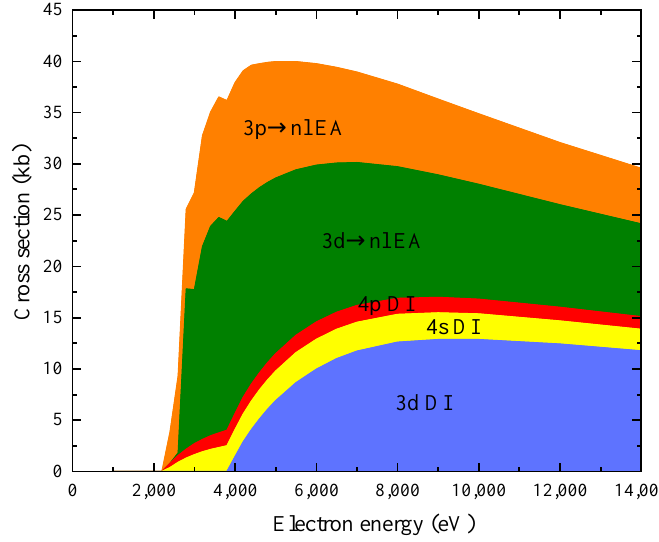
Figure 7. Accumulated DI and EA cross-sections of ground state W 43 + . The shadow areas show contributions from different subshells (1.0 kb = 10 − 21 cm 2 ).